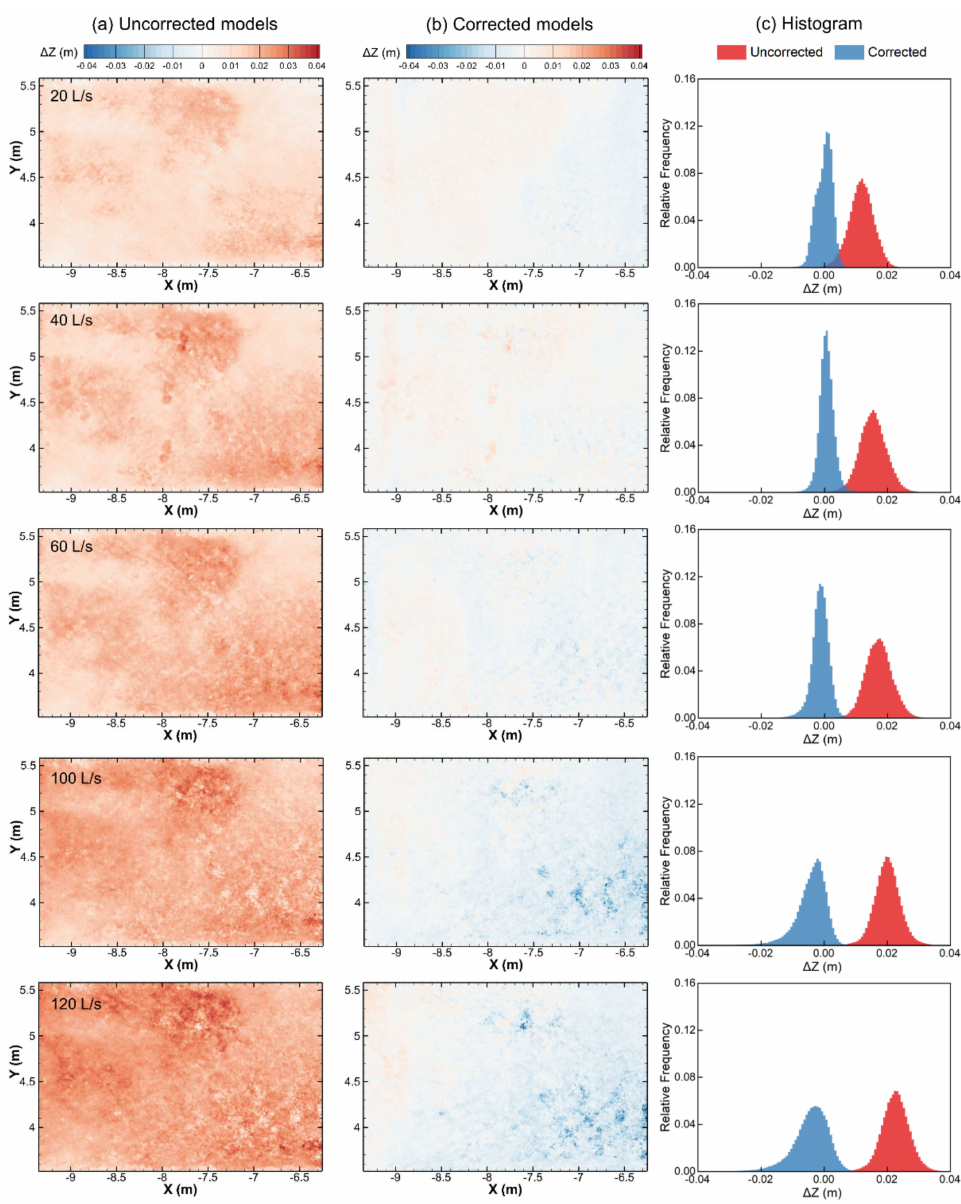
Figure 8. The contours and histograms of elevation errors for the through-water SfM models using the bed GCPs for MR2: ( a ) uncorrected models; ( b ) corrected models; ( c ) histograms. Flow goes from the left to the